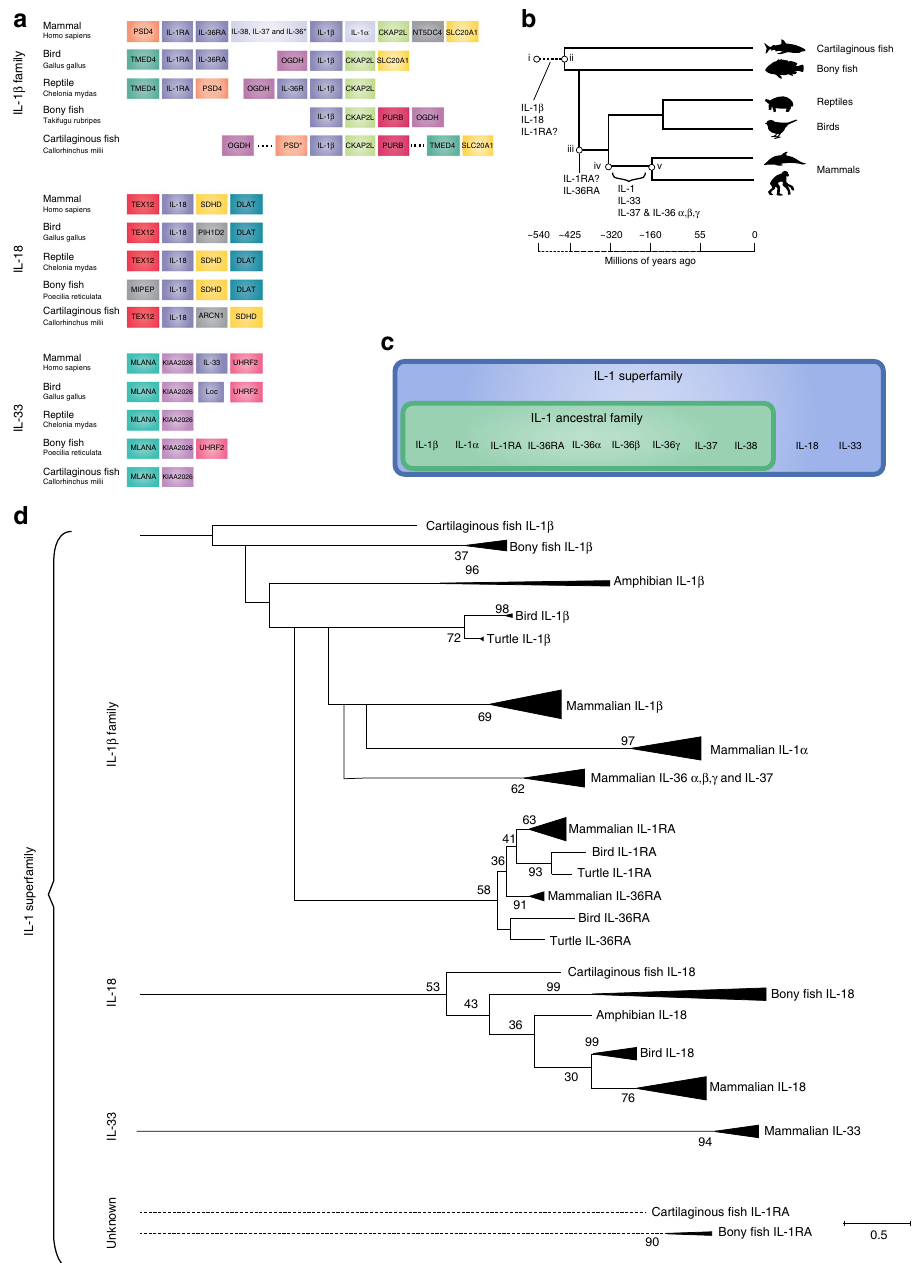
Fig. 2 Evolutionary history of the IL-1 ligand family. a Chromosomal gene location as evidence of ancestral relationship of IL-1 family members. The highly conserved nature of surrounding genes suggests three separate evolutionary families, as follows: IL-1 β , IL-18, and IL-33. b A simpli fi ed evolutionary tree with time scale of cartilaginous and bony fi sh, birds, reptiles, mammals and the approximate time line of the evolutionary occurrence of IL-1 family members 54,55 . IL-1 β and IL-18 are expressed exclusively in all vertebrate species, including cartilaginous fi sh, suggesting that they evolved prior to the divergence of bony and cartilaginous fi sh ~425 million years ago (ii); IL-1 α , IL-33 and IL-36 α , β & γ are expressed exclusively in mammals therefore likely formed in the common ancestor of all mammals (Synapsid lineage) (iv). This event must have occurred after divergence of the Synapsid lineage (iv) 320 million years ago but prior to the divergence of mammals 160 million years ago (v). c An ancestral and superfamily scheme of the IL-1 ligands. d Composite evolutionary history of the IL-1 family of cytokines constructed by overlaying the evidence from chromosomal location and clade IL-1 family gene pro fi le on to the maximum likelihood tree from Supplementary Data 2. The percentage of trees in which the associated group clustered together is shown next to the branches from 1000 bootstrap replications. Primary branches that occur in <50% of trees were collapsed. The tree is drawn to scale, with branch lengths measured in the number of amino acid replacements per site. The analysis involved 155 amino acid sequences with a fi nal alignment length of 64 positions. All positions containing gaps and missing data were eliminated. Scale bar is 0.5 replacements per